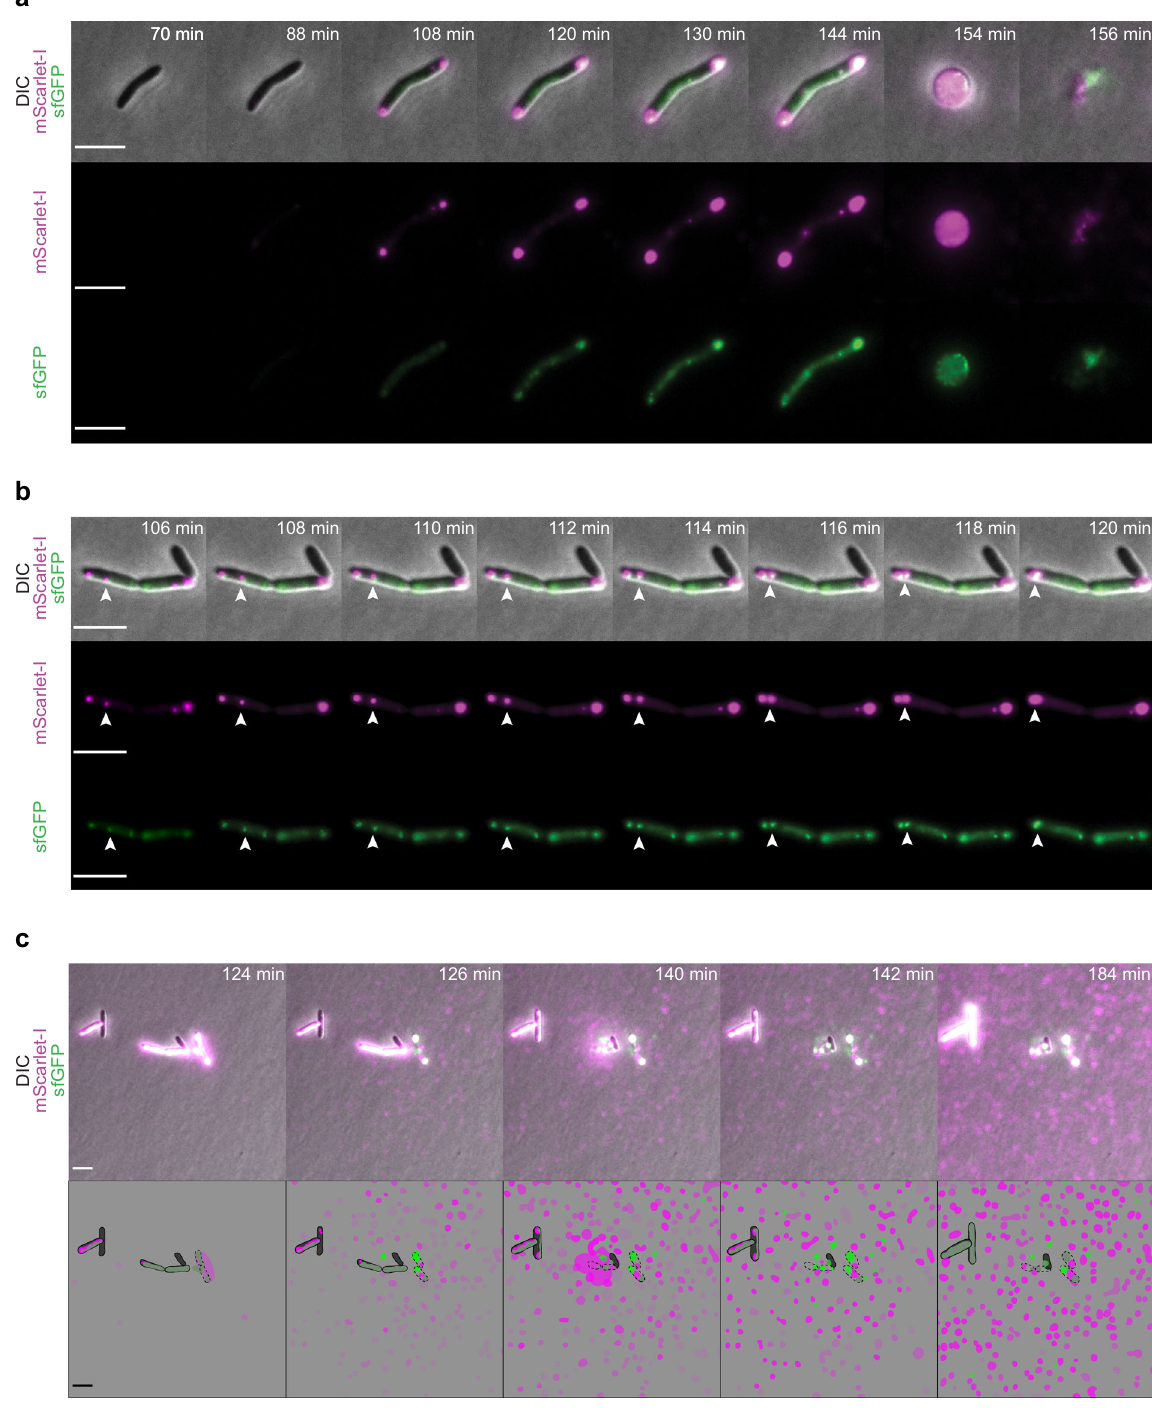
Fig. 4 Temporal and spatial formation and release of tailocins #1 and #2 in Pseudomonas protegens CHA0 cells following induction with mitomycin C. Panels a, b, c show the different examples of the production dynamic of the two R-tailocins. a and b R-tailocins are produced at the center of the cell and migrate to cell poles. Following this migration, the cell undergoes a two-step lysis: fi rstly by forming a spheroblast and then completely lysing. c When the cell lyses, R-tailocins are thrusted into the medium. The proteins making up the sheaths of the tailocins #1 and #2 were tagged with the fl uorescent proteins mScarlet-I (magenta) and sfGFP (green), respectively. Cells were monitored post induction using time-lapse microscopy (see Supplementary Movies 1, 2, 3); time post induction is indicated in the upper right corner of panels. In panel c , the brightness was arti fi cially enhanced to better visualize the R-tailocins in the medium. The succinct increase in tagged tailocins in the background in particular between time points 142 min and 184 min is due to cells out of the frame also producing tailocins. Cartoons depict the release of R-tailocins at different time points. CHA0 live cells are shown in gray while ghost cells are outlined with a dotted line. Tailocins #1 and #2 are illustrated in magenta and green, respectively. The scale bars represent 5 µ